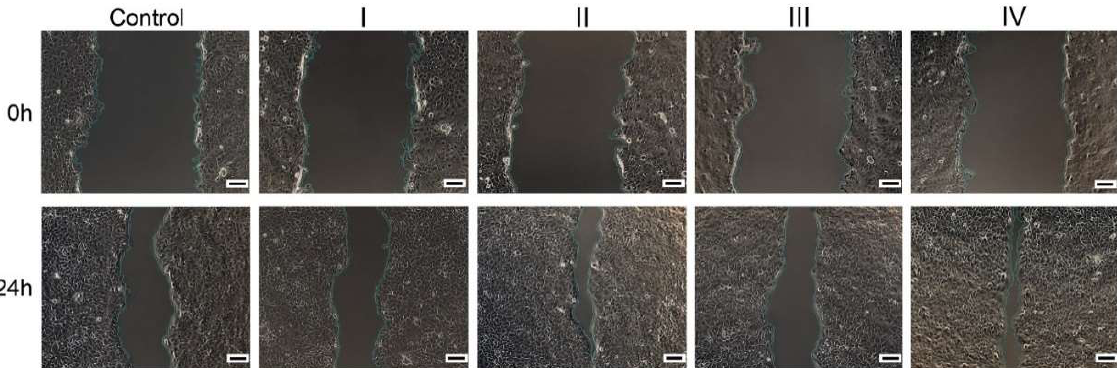
Figure 6. Optical microscopy images of wounded human keratinocyte monolayers (HaCaT, ECACC) (Control) and treated with the four formulations at time 0, immediately after the scratch, and after 24 h of cultivation. Scale Bar = 100 µm.